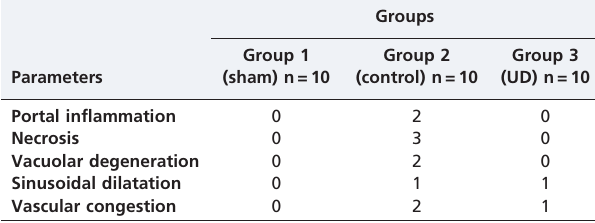
Table 2 - Median histological injury scores* of liver tissue.